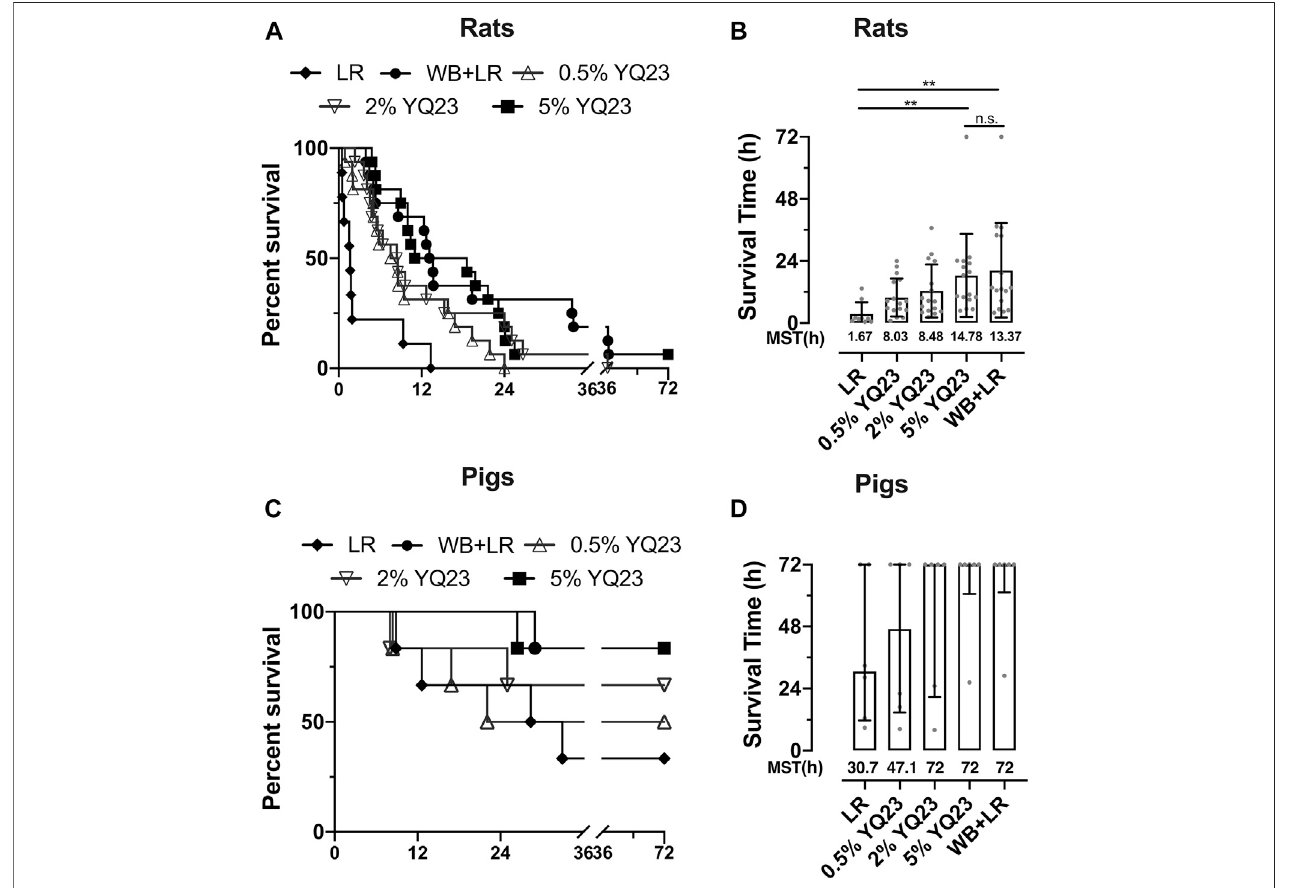
FIGURE7|YQ23improvedanimalsurvivalfollowinguncontrolledhemorrhagicshock.(A) ,thesurvivalcurveofrats( n (cid:1) 16/group); (B) ,survivaltimeofrats ( n (cid:1) 16/group); (C) ,survivalcurveofpigs( n (cid:1) 6/group); (D) ,survivaltimeofpigs( n (cid:1) 6/group).LR,LactateRinger ’ ssolution;WB,wholeblood;MST,mediansurvivaltime. * p < 0.05, ** p < 0.01, n. s., not signi fi